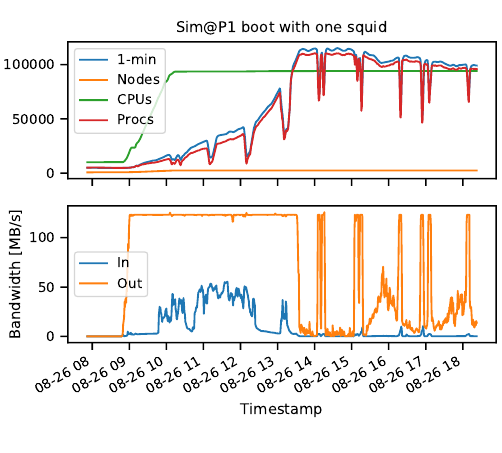
Figure 1. The top figure shows the number of instances, CPUs, and running processes as well as the aggregate one minute load on the TDAQ HLT farm as it transitions to o ffl ine mode. Below, using the same timestamps, the network load on the single Frontier proxy delivering the CVMFS content to all the nodes is displayed. The correlation of saturated outgoing bandwidth in the lower plot with the steady increase in the load and processes in the upper plot suggests the squid is the rate determining system in the transition of the farm.